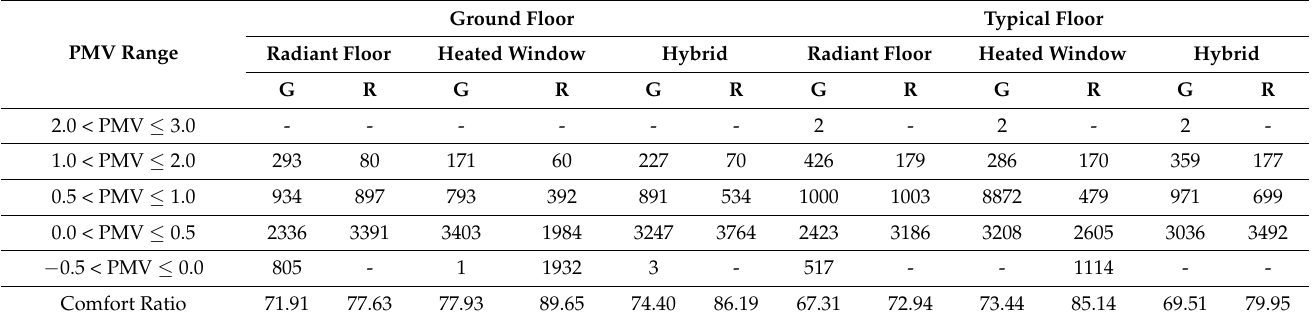
Figure 9. Ratio of comfort time for each model. Table 8. Cumulative hours for various ranges of PMV and comfort ratio (−0.5 ≤ PMV ≤ 0.5).